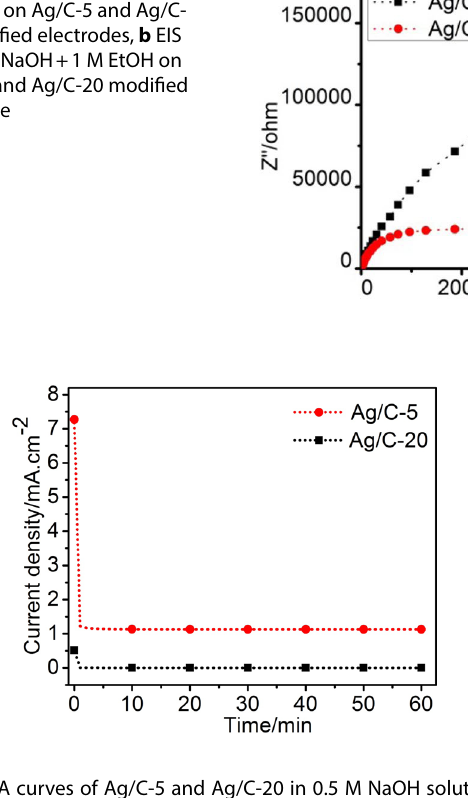
Fig. 5 CA curves of Ag/C-5 and Ag/C-20 in 0.5 M NaOH solution at 0.3 V